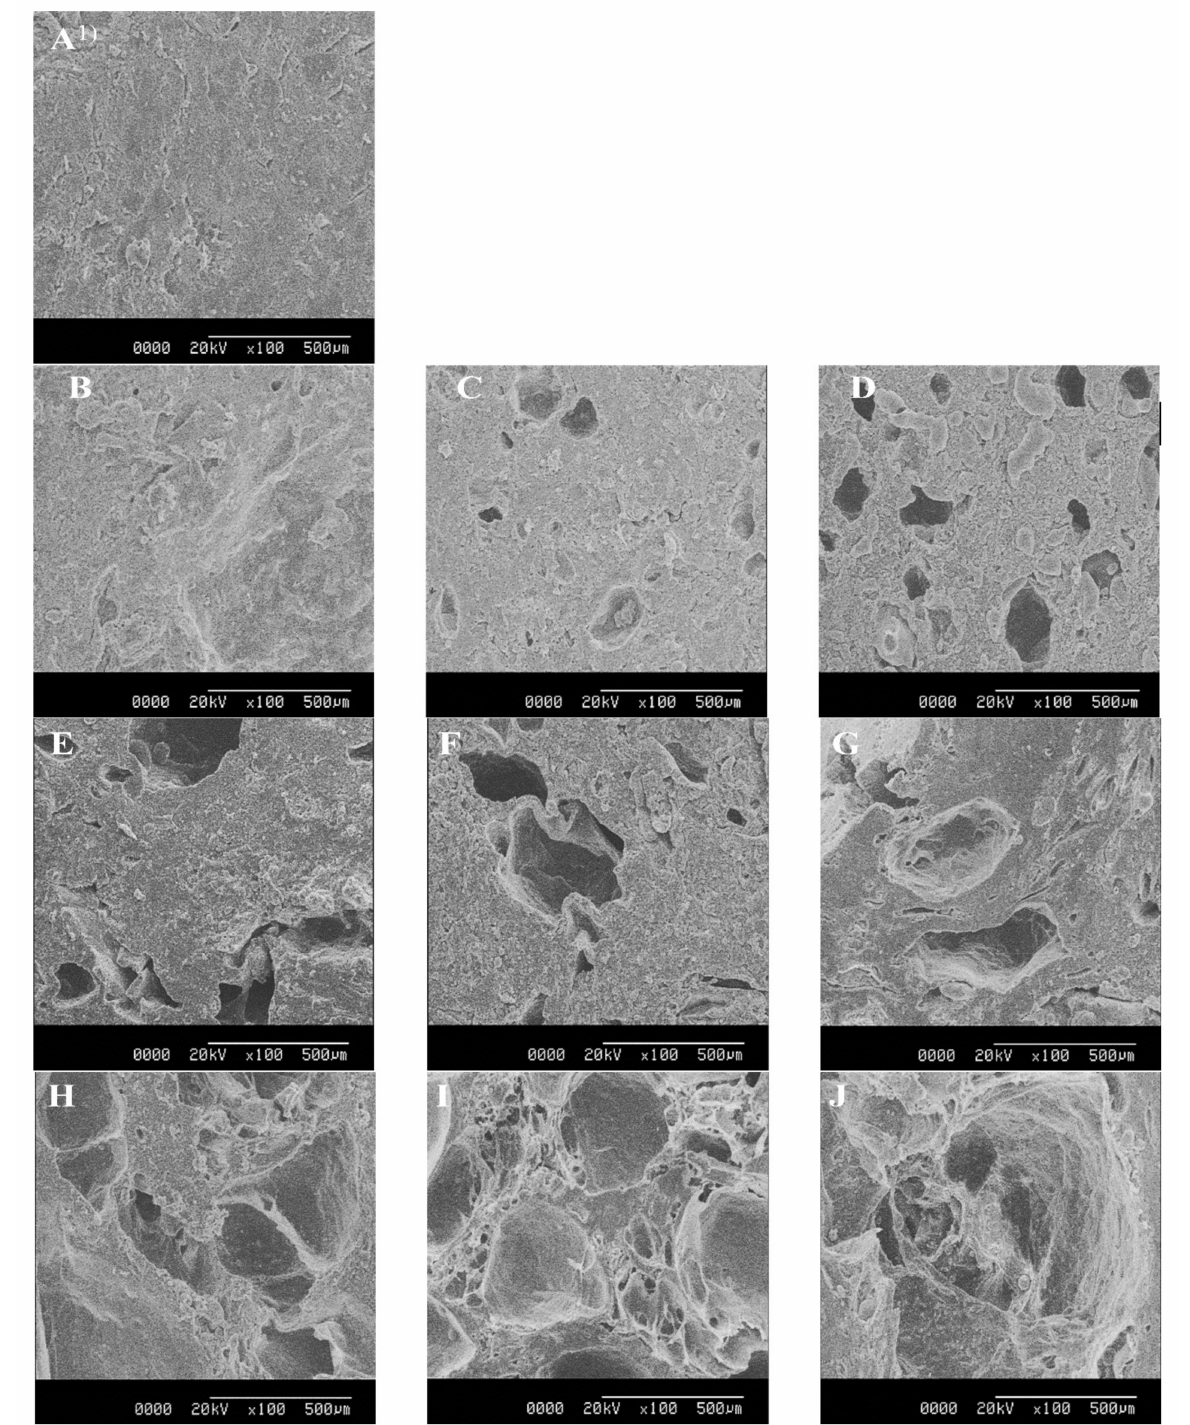
Figure 1. Scanning electron microscopy of semi-dried restructured jerky processed with super-heated steam (SHS) ( A ), hot air drying (control); ( B – D ) super-heated steam drying at 200 ◦ C for 90, 105, and 120 min; ( E – G ) super-heated steam drying at 250 ◦ C for 90, 105, and 120 min; ( H – J ) super-heated steam drying at 300 ◦ C for 90, 105, and 120